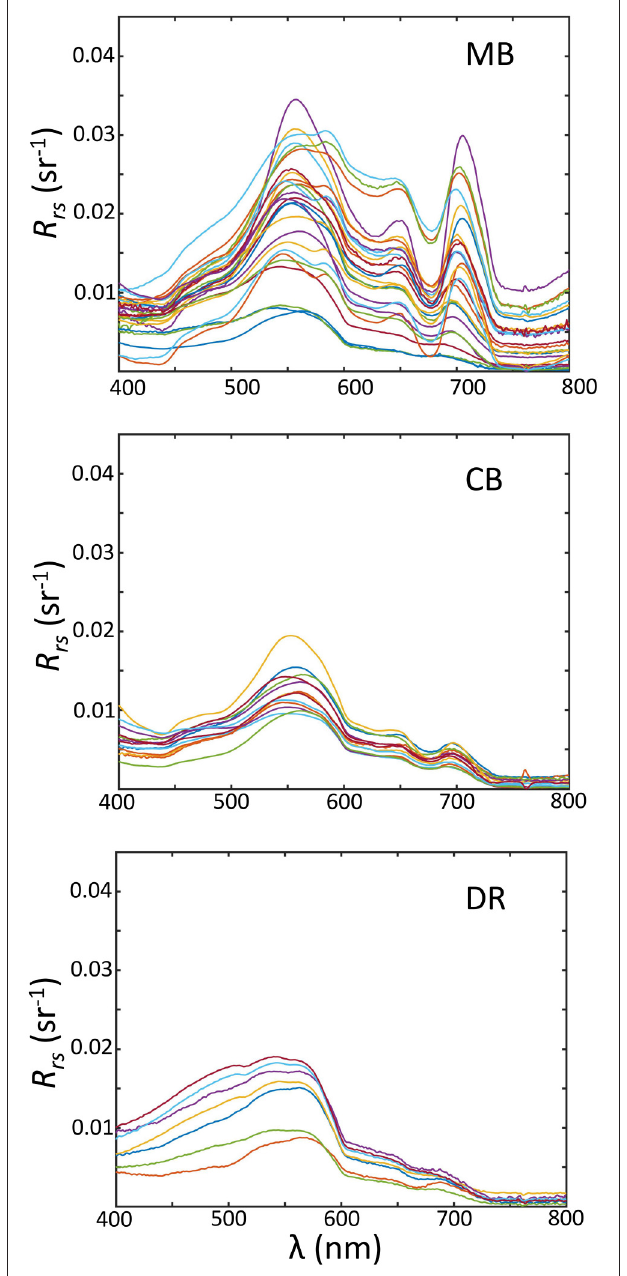
FIGURE 10 | Above-water remote sensing reflectance measurements sorted by geographic/hydrographic regions; (Top) the Maumee Bay region (MB); (Middle) the Central Basin (CB); (Bottom) the Detroit River Plume